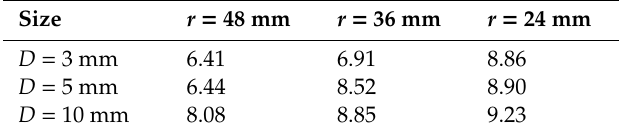
Table 2. Reconstruction error when using double frequency data.